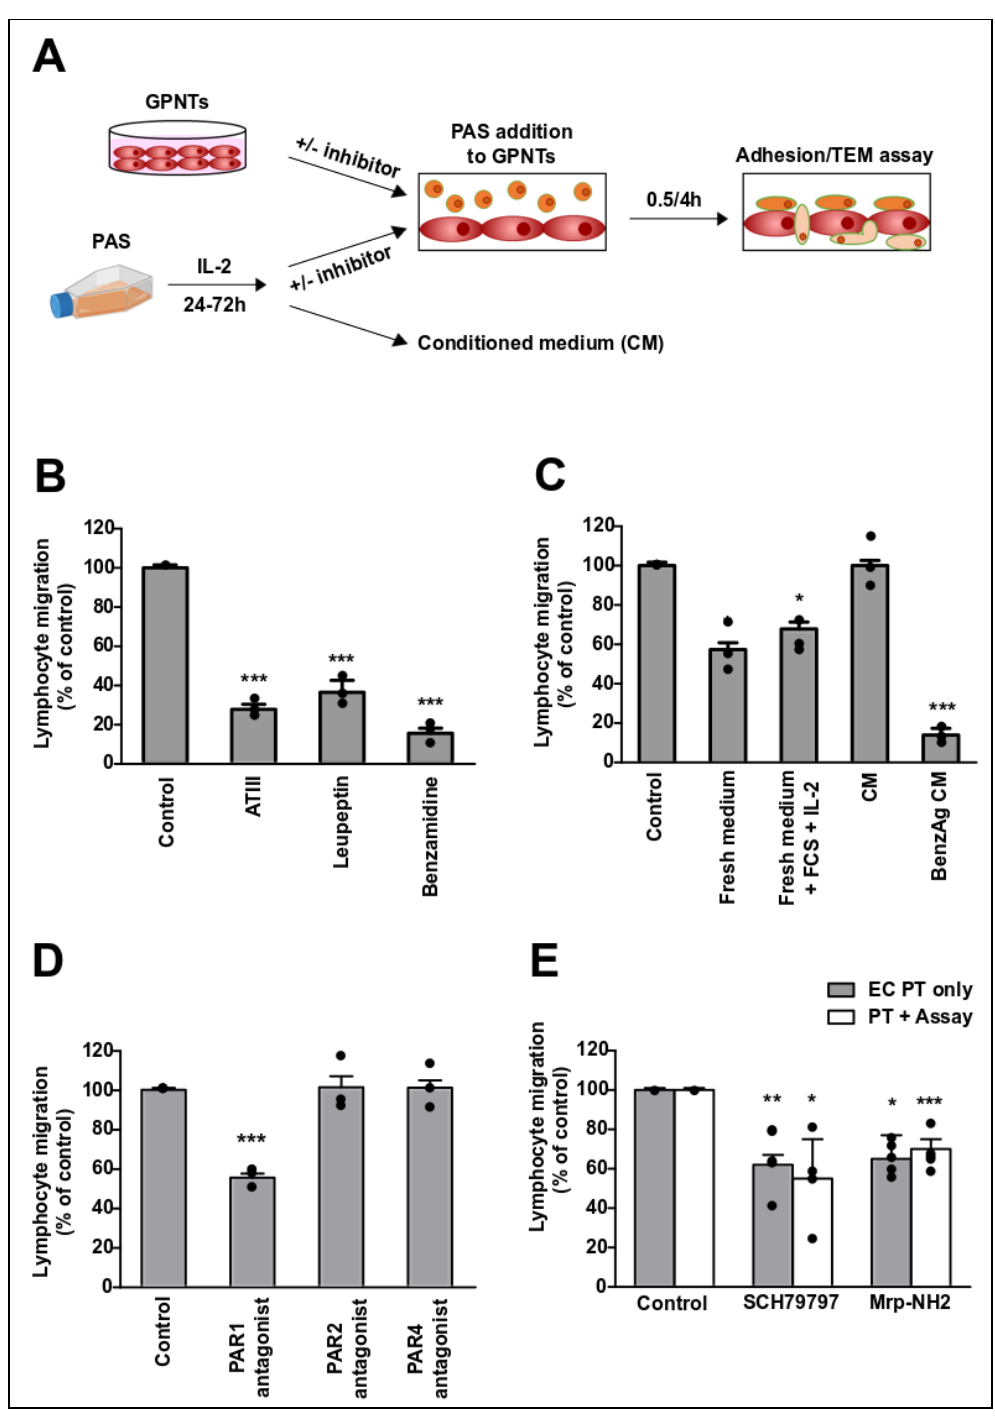
Figure 1. A T cell-secreted protease activates endothelial PAR1 during TEM. ( A ) Schematic of the experimental setup. GPNT blood–brain barrier (BBB) endothelial cells (ECs) were grown to confluence. PAS Th1 cells were activated in medium with IL-2 for 24–72 h. For some experiments the conditioned medium (CM) generated after 24 h was used separately. Optionally, GPNT or PAS were treated with inhibitors before PAS were added to the GPNT monolayer. Adhesion and TEM rates were assessed 0.5–4 h later. All PAS in contact with GPNT monolayers (apical, within, basal) were counted for adhesion. All PAS within and underneath were counted for TEM rates. ( B ) TEM assays were conducted in